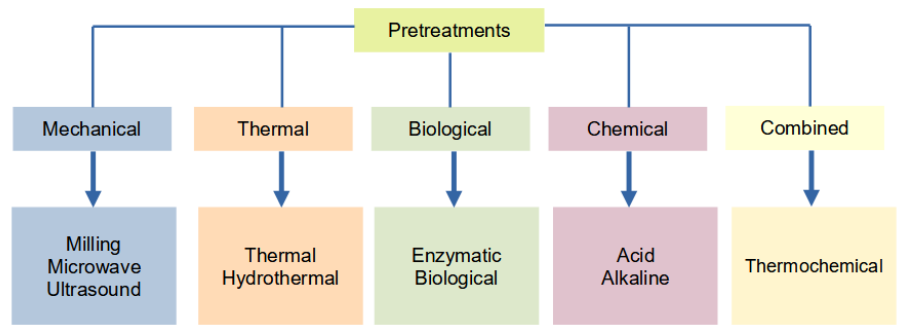
Figure 1. The main algal biomass pretreatment methods aimed at methane production.